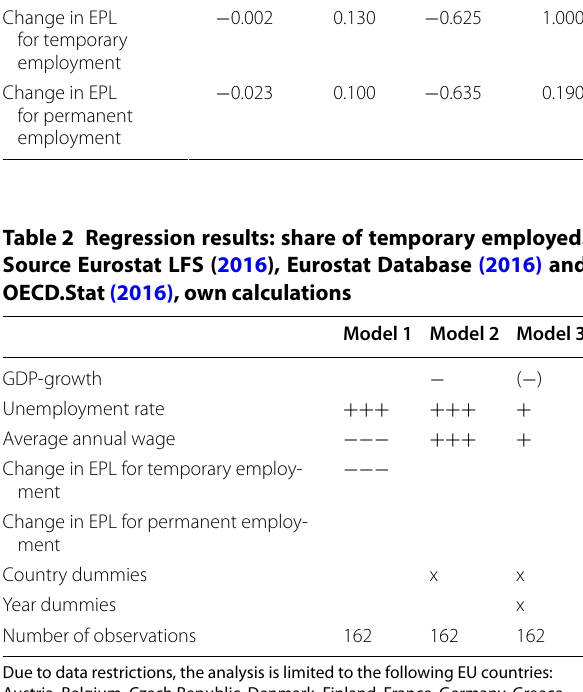
Due to data restrictions, the analysis is limited to the following EU countries: Austria, Belgium, Czech Republic, Denmark, Finland, France, Germany, Greece, Hungary, the Netherlands, Poland, Portugal, Slovak Republic, Spain, Sweden and the UK Significance level: /--- p < 0.01; /- p < 0.1; (-) borderline +++ +